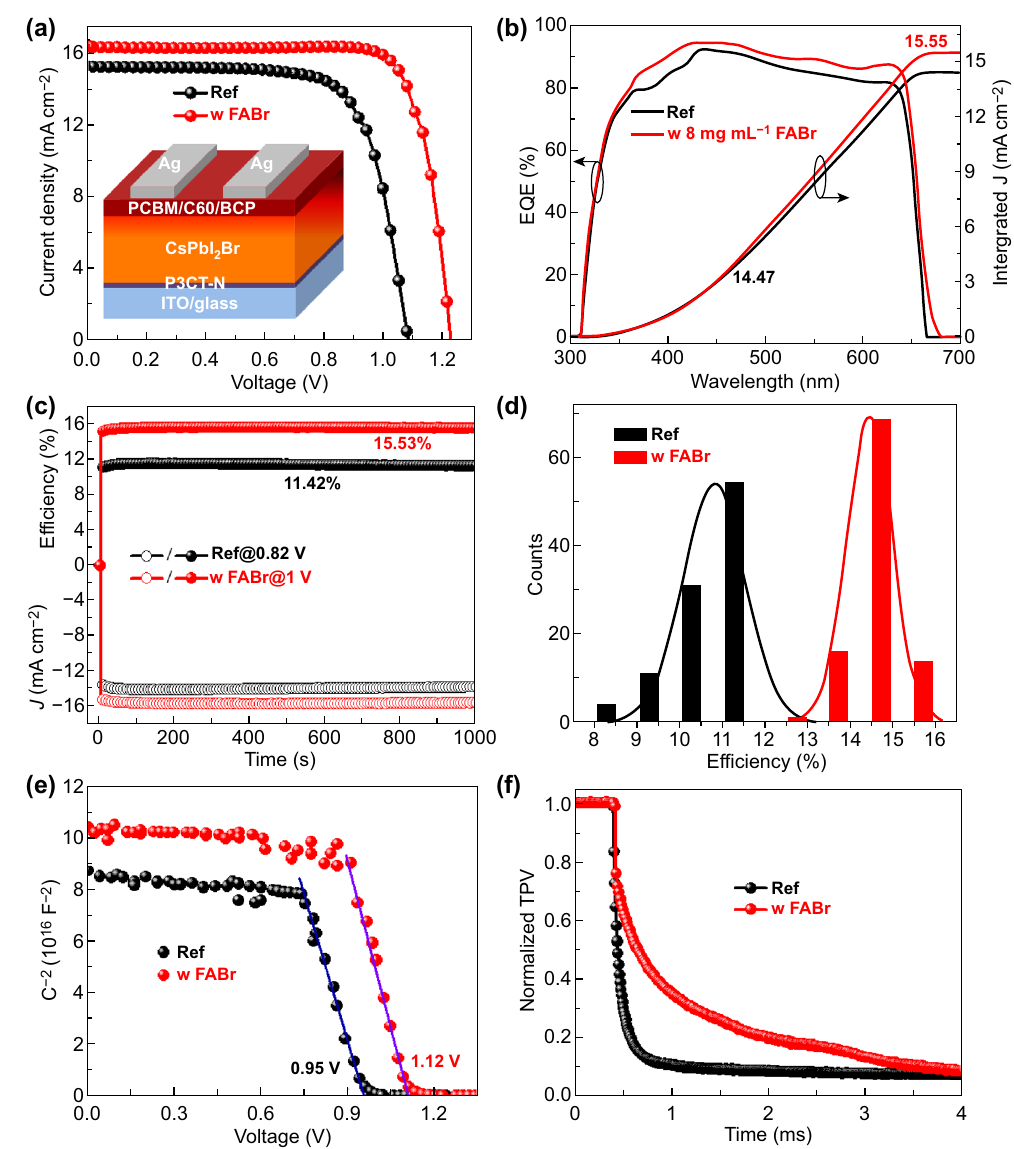
Fig. 4 a J - V curves of the champion devices fabricated from the 8F film (red line) and Ref (black line), and the inset image is the schematic of device. b EQE spectrum of related devices. c Stabilized maximum power out with the champion devices. d Efficiency statistic of the Ref and 8F CsPbI 2 Br cells. e Mott–Schottky spectra and f TPV analysis of the Ref and 8F